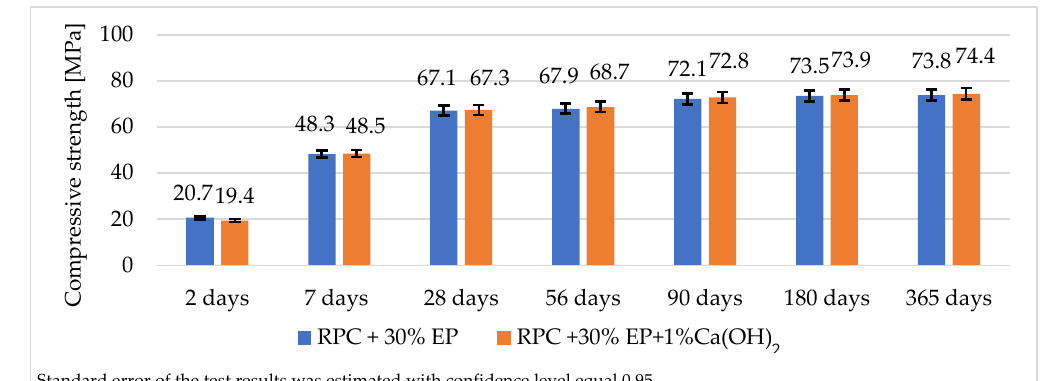
Standard error of the test results was estimated with confidence level equal 0.95. Materials 2021 , 14 , x FOR PEER REVIEW Figure 15. Compressive strength of RPC containing 30 vol.% of expanded perlite without and with addition of 1% Ca(OH) 2 .